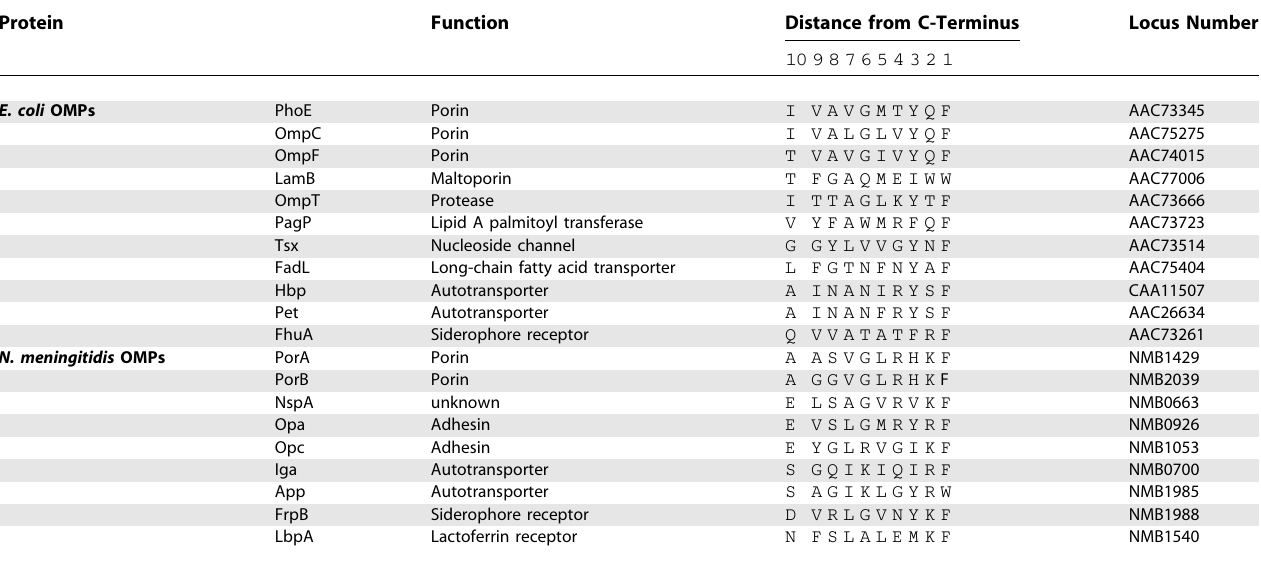
Table 1. C-Terminal Ten Amino Acids of Selected E. coli and N. meningitidis OMPs Protein Function Distance from C-Terminus Locus